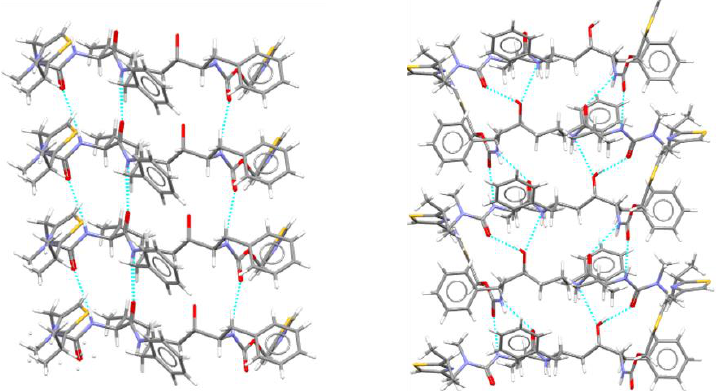
Figure 11. The hydrogen bonding networks in crystals of Ritonavir form I ( left ) and form II ( right ) [38].